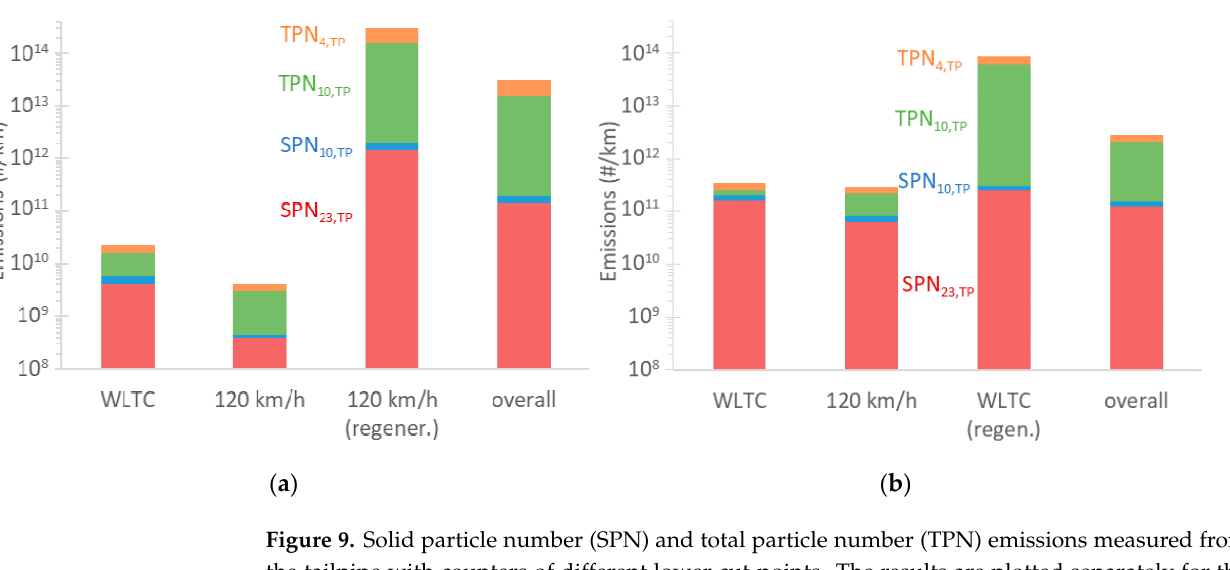
Figure 9. Solid particle number (SPN) and total particle number (TPN) emissions measured from the tailpipe with counters of different lower cut-points. The results are plotted separately for the worldwide harmonized light vehicles test cycle (WLTC) and 120 km/h, without and with active regeneration, and the overall (i.e., weighted with one regeneration event) emissions: ( a ) Vehicle #1 (Euro 6d-Temp); ( b ) Vehicle #2 (Euro 6b).